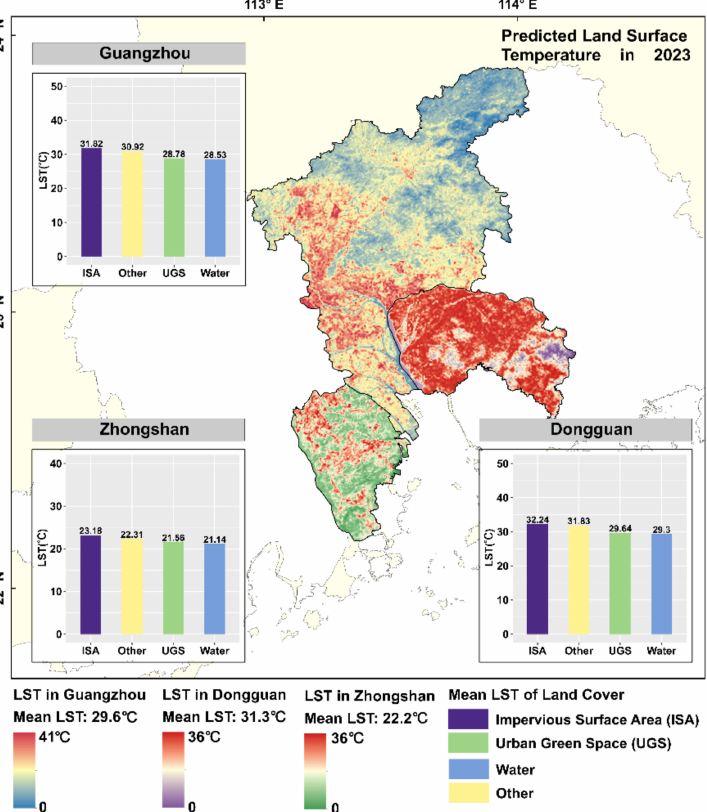
Figure 16. Predicted LST and the average LST corresponding to each LSC in 2023 across Guangzhou, Dongguan and Zhongshan using the BP neural network model under the natural scenario of the LCS